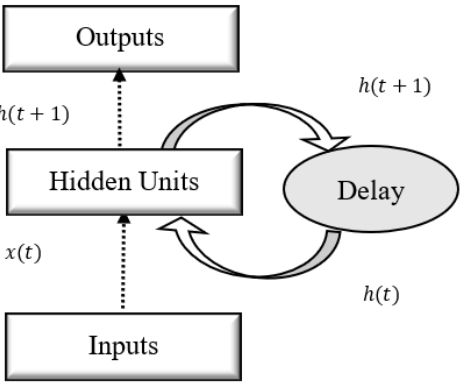
Figure 8. The recurrent neural network diagram showing the unit arrangement.